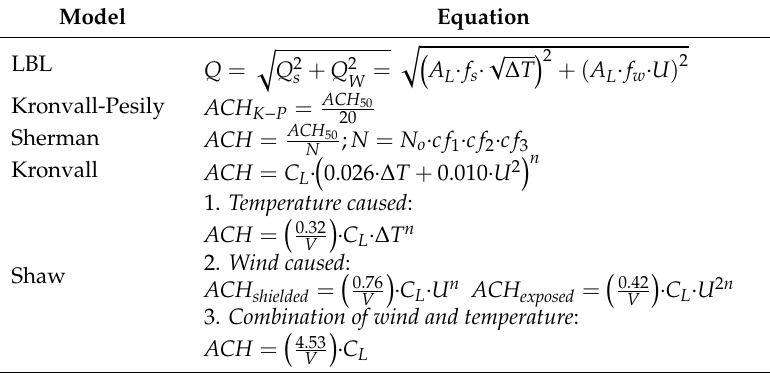
Table 2. Air infiltration models based on airtightness test